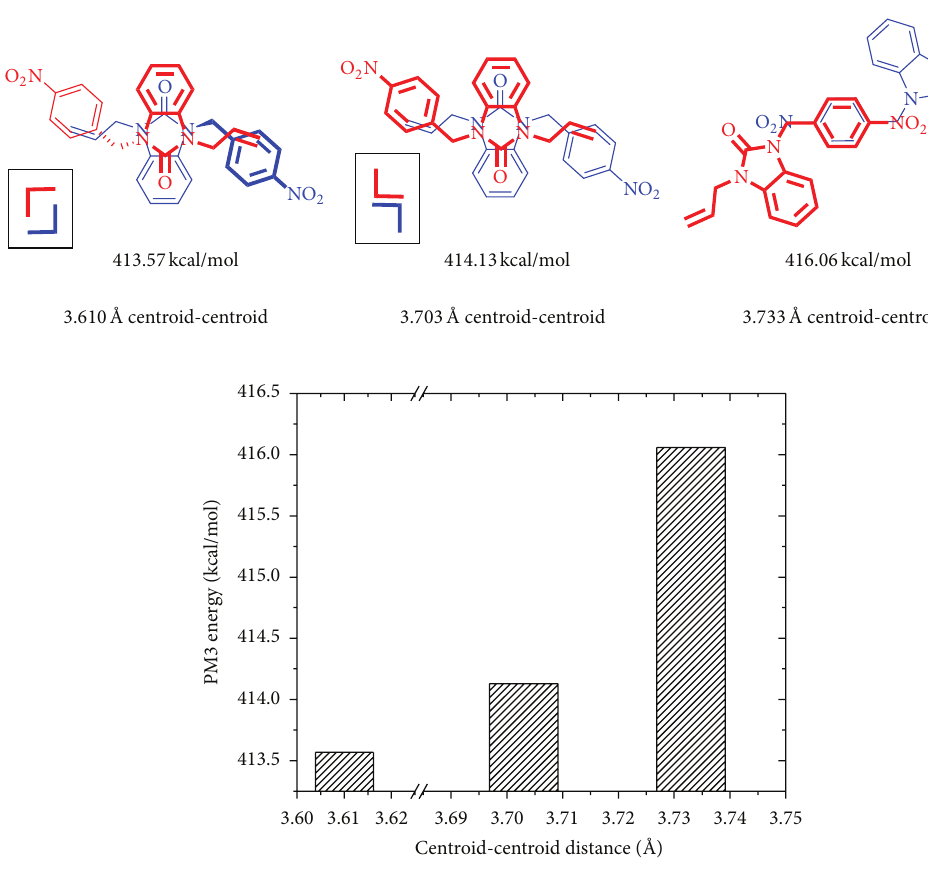
Figure 10: Calculated energy for the dimers observed at the X-ray crystal structure.